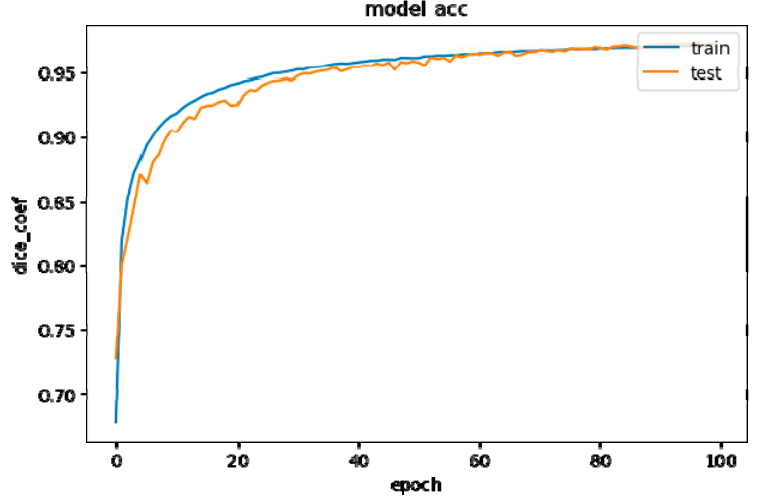
Figure 10. Training performance using a mix of LiTS and KCGMH with a total of 4000 images.